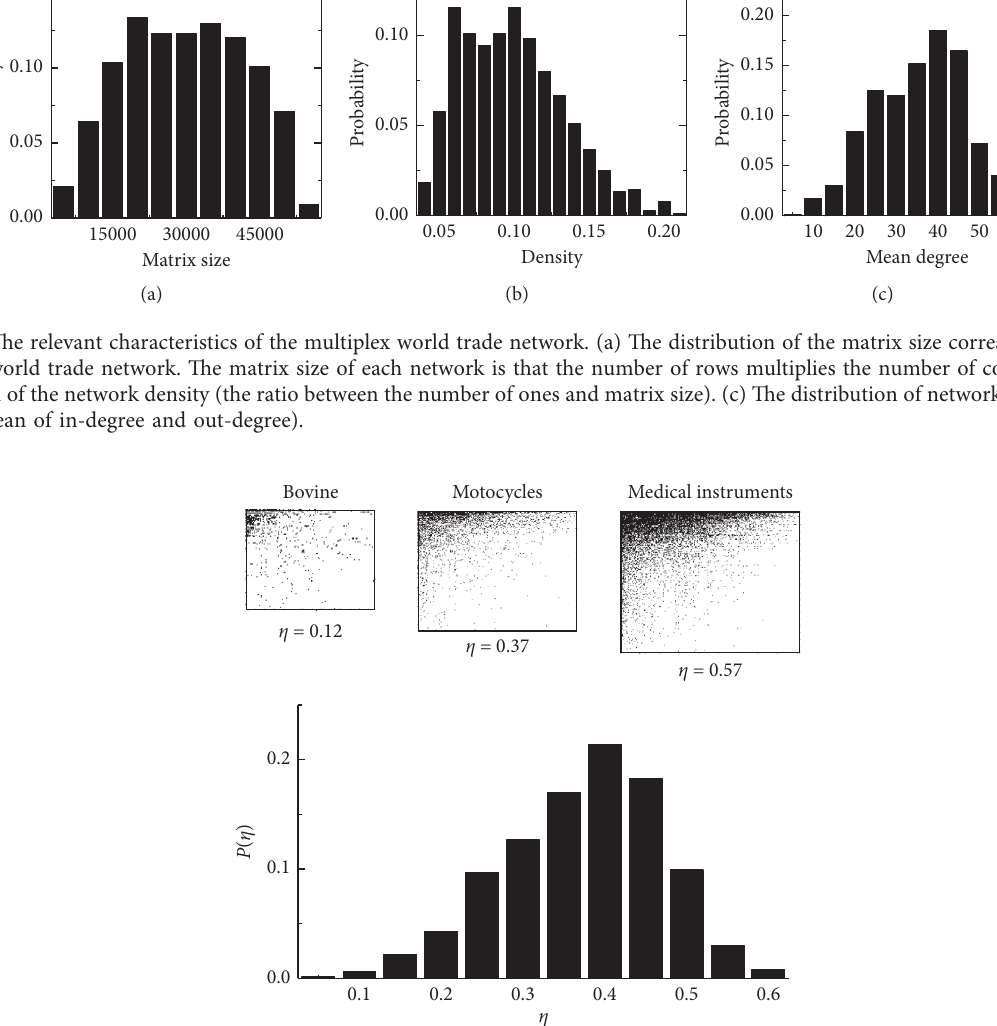
Figure 3: Nested structure in world trade networks. (a) The three matrices are representations of the different layers of world trade networks which respectively correspond to the network of bovine, motorcycles, and medical instruments. The shape of these three matrices (i.e., the number of rows and columns) is 136 ∗ 96, 212 ∗ 174, and 228 ∗ 210. The nestedness of matrices ( η ) is 0.12, 0.37, and 0.57, respectively. (b) The curve is the distribution of nestedness calculated by all matrices of products.